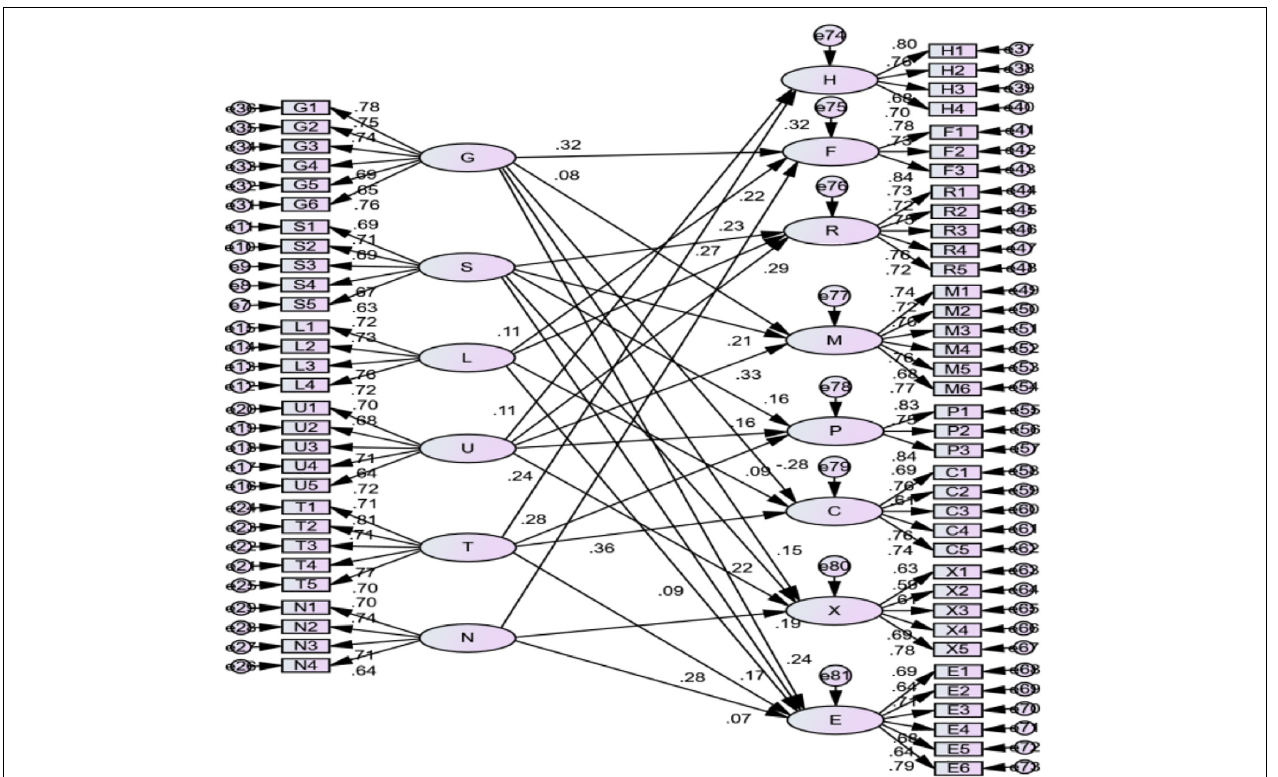
FIGURE 4 | Initial structural equation